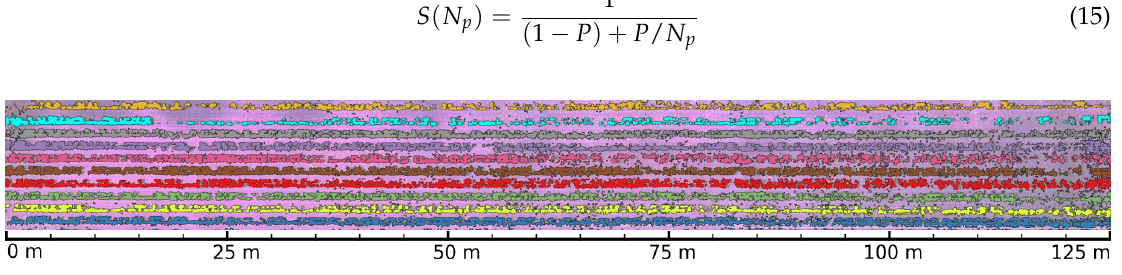
Figure 8. Area division for parallel execution. Each color represents vegetation areas evaluated by the same computer